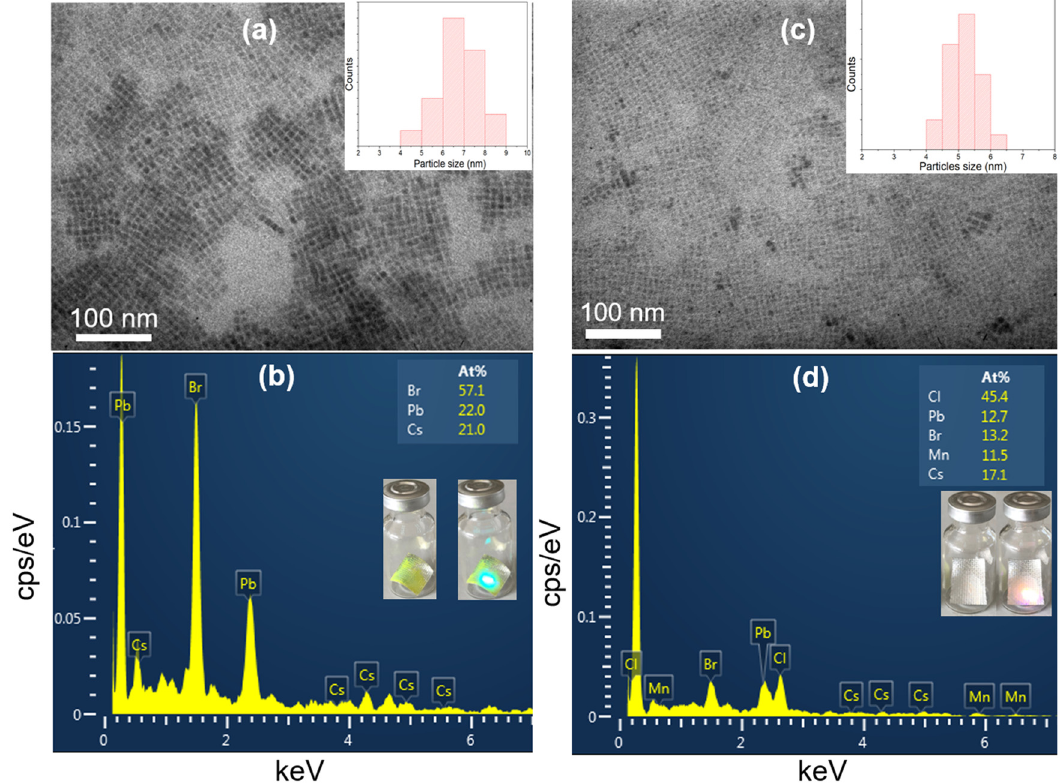
Figure 3: SEM images and EDX spectra of ( a and b ) CsPbBr 3 and ( c and d ) CsPb 1 – x Mn x Br 3 – 2 x Cl 2 x ( x = 0 – 0.5 )